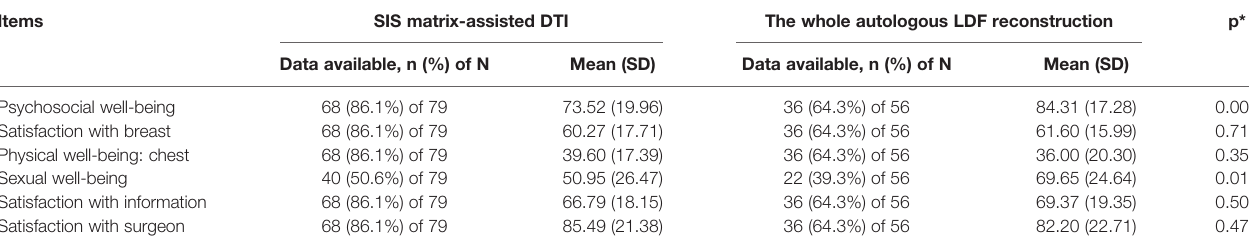
TABLE 5 | Postoperative scales of BREAST-Q Version 2.0 between DTI and autologous LDF breast